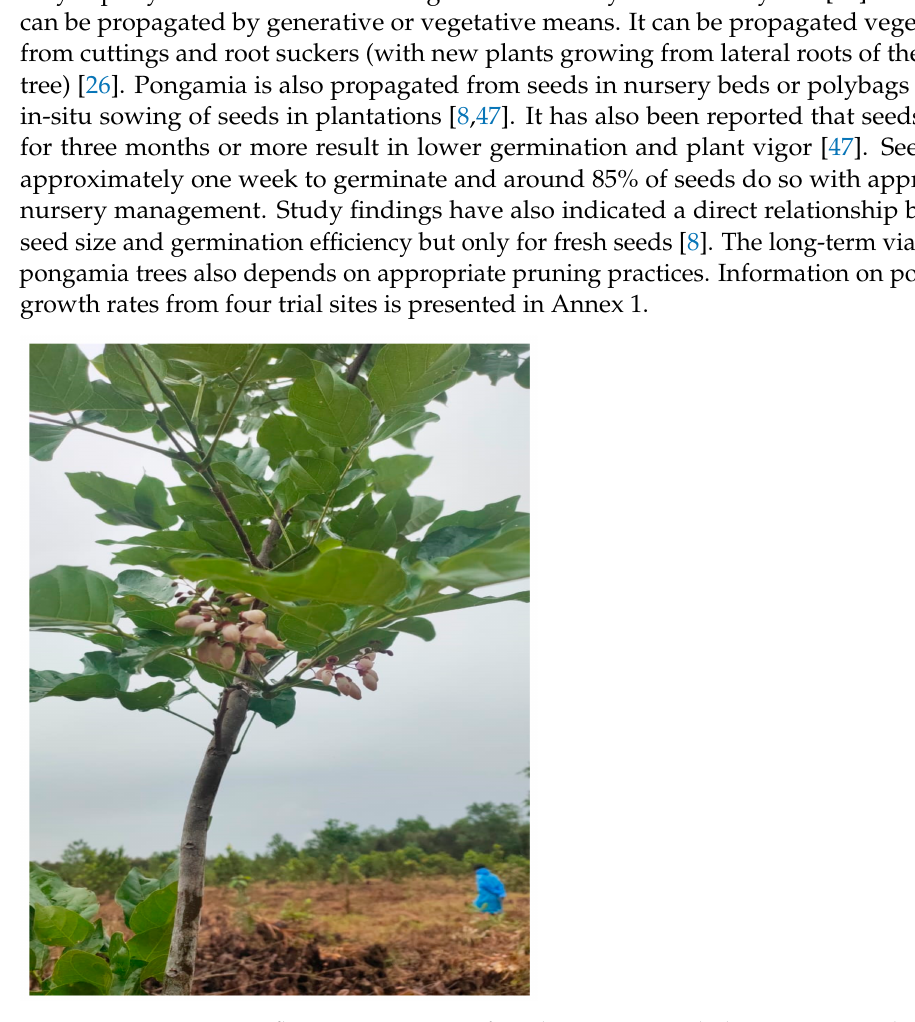
Figure 3. Pongamia tree flowering 1.5 years after planting in a trial plot in Buntoi, Pulang Pisau, Central